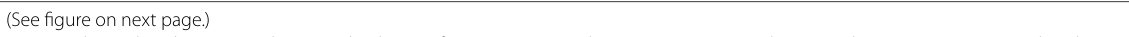
(See figure on next page.) Fig. 2 Relationships between pulmonary dead‑space fraction ( V D / V T ) and some respiratory mechanics and oxygen parameters at baseline and 24 h after. a Scatter plot depicting the correlation between pulmonary dead‑space fraction ( V D / V T ) and the PaO 2 /FiO 2 ratio at baseline. b Scatter plot depicting the correlation between pulmonary dead‑space fraction ( V D / V T ) and the PaO 2 /FiO 2 ratio 24 h after. c Scatter plot depicting the correlation between pulmonary dead‑space fraction ( V D / V T ) and PEEP levels at baseline. d Scatter plot depicting the correlation between pulmonary dead‑space fraction ( V D / V T ) and PEEP levels 24 h after. e Scatter plot depicting the correlation between pulmonary dead‑space fraction ( V D / V T ) and the V T / C RS at baseline. f Scatter plot depicting the correlation between pulmonary dead‑space fraction ( V D / V T ) and the V T / C RS 24 h after. g Scatter plot depicting the correlation between pulmonary dead‑space fraction ( V D / V T ) and Pm aw at baseline. h Scatter plot depicting the correlation between pulmonary dead‑space fraction ( V D / V T ) and Pm aw 24 h after. PaO 2 /FiO 2 ratio: arterial oxygen partial pressure to oxygen inspiratory fraction; PEEP: positive end‑expiratory pressure; V T / C RS : tidal volume‑to‑respiratory system compliance ratio (i.e., driving pressure); Pm aw : mean pressure of the